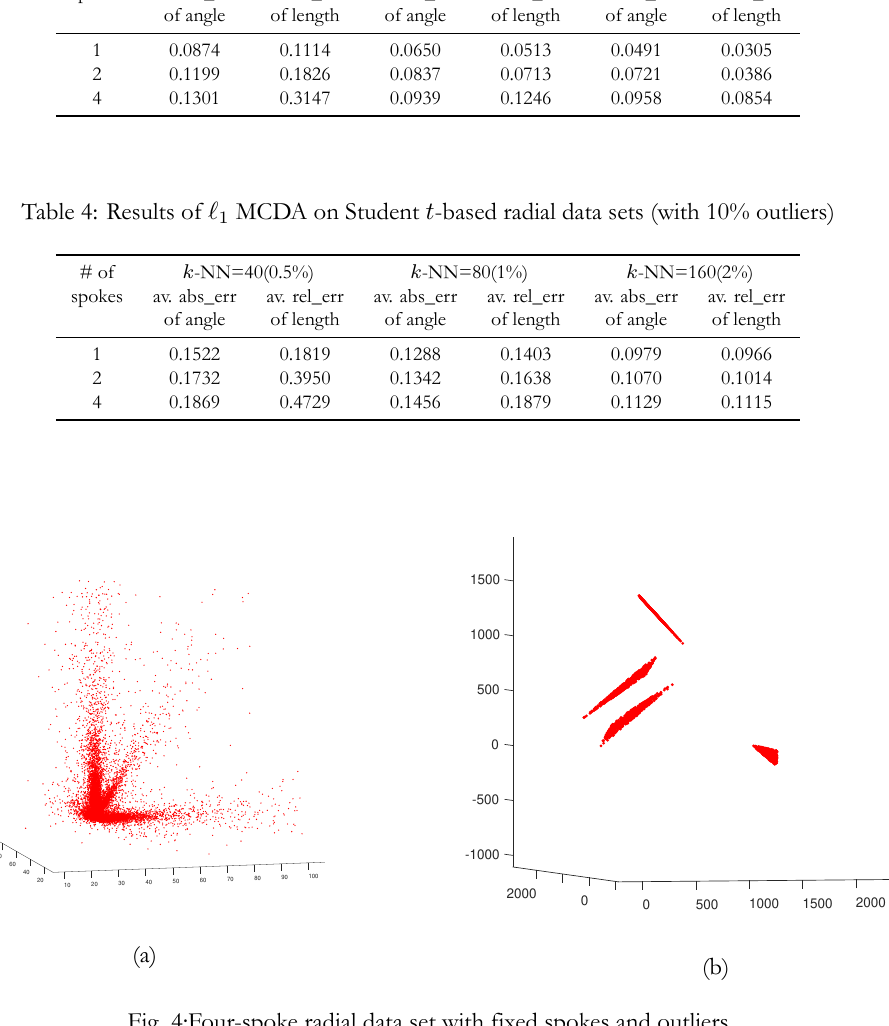
Fig. 4:Four-spoke radial data set with fixed spokes and